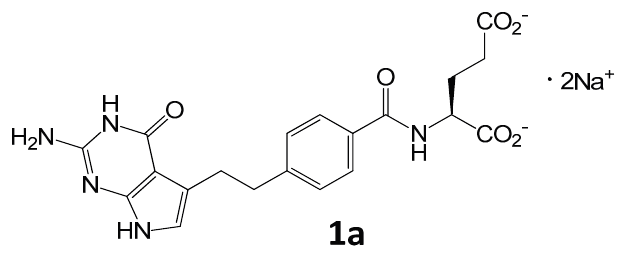
Figure 1. Chemical structures of pemetrexed as the disodium salt 1a